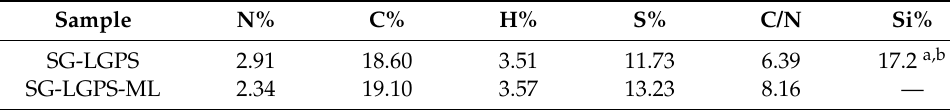
Table 4. Elemental analysis on SG-LGPS and SG-LGPS-ML.